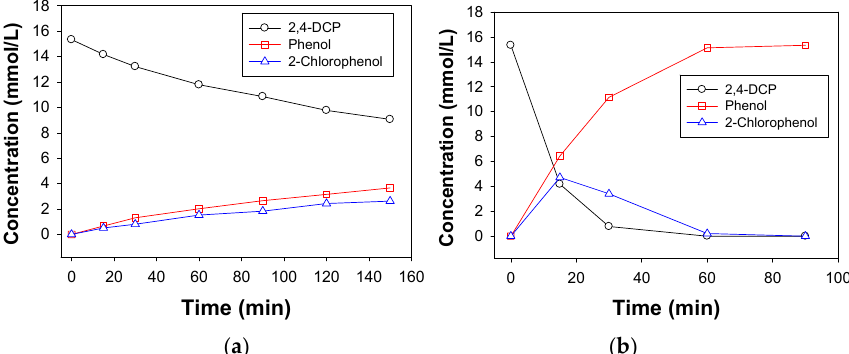
Figure 5. The concentrations of 2,4-DCP, 2-Chlorophenol and phenol as a function of reaction time over ( a ) Pd/AC and ( b ) Pd/N-AC.